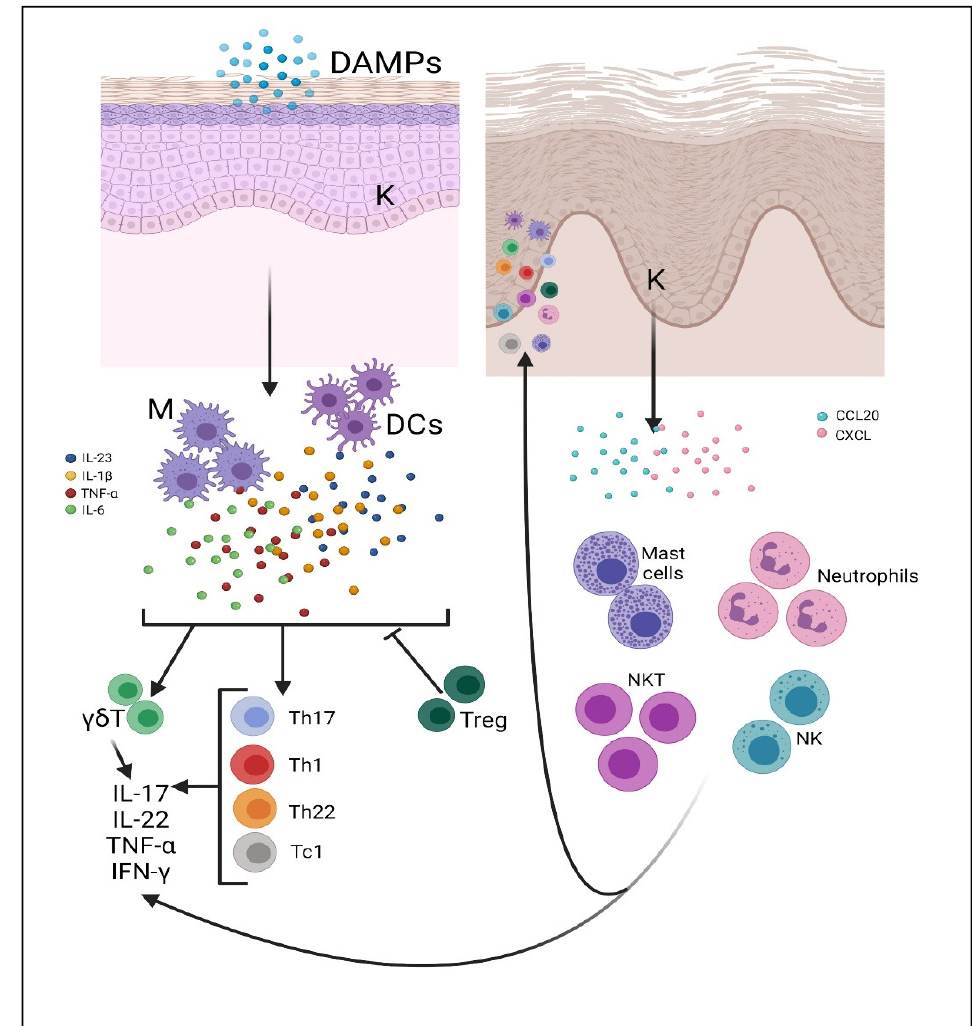
Figure 3. The pathogenetic mechanism of psoriasis. DAMPs activate DCs and macrophages by inducing the secretion of IL-23, IL-1 β , IL-6, and TNF- α . They stimulate the TCD4+ (Th1, Th17, Th22) and CD8+ (Tc1)-mediated immune response. Mast cells, neutrophils, NK and NKT cells, and other immune cells infiltrate the site of phlogosis in the skin, contributing to disease progression by releasing IL-17 and antimicrobial peptides. Treg cells lose their suppressive activity and, in some cases, convert to Th17 cells, further increasing the local inflammatory reaction. Cytokines and chemokines act on keratinocytes, inducing their hyperproliferation. Activated keratinocytes produce CCL20 and CXCL1, 3, 8, 11, increasing cell infiltration. This creates an amplified continuous cycle that leads to injury. Abbreviations: M, macrophages; K, keratinocytes. Created with BioRender.com (accessed on 18 February 2022).